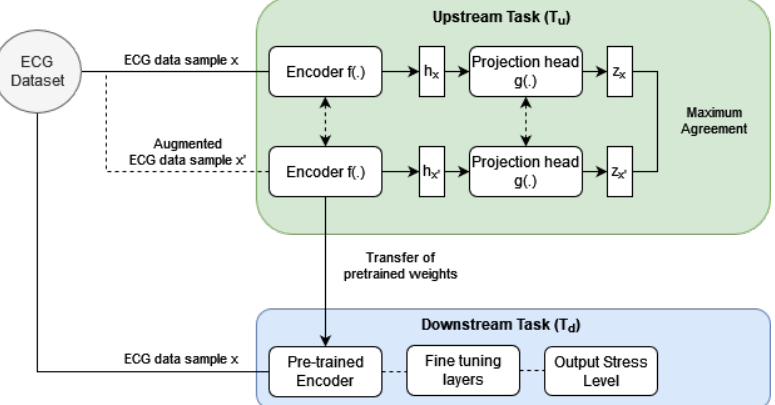
Figure 1. Overview of the contrastive SSL